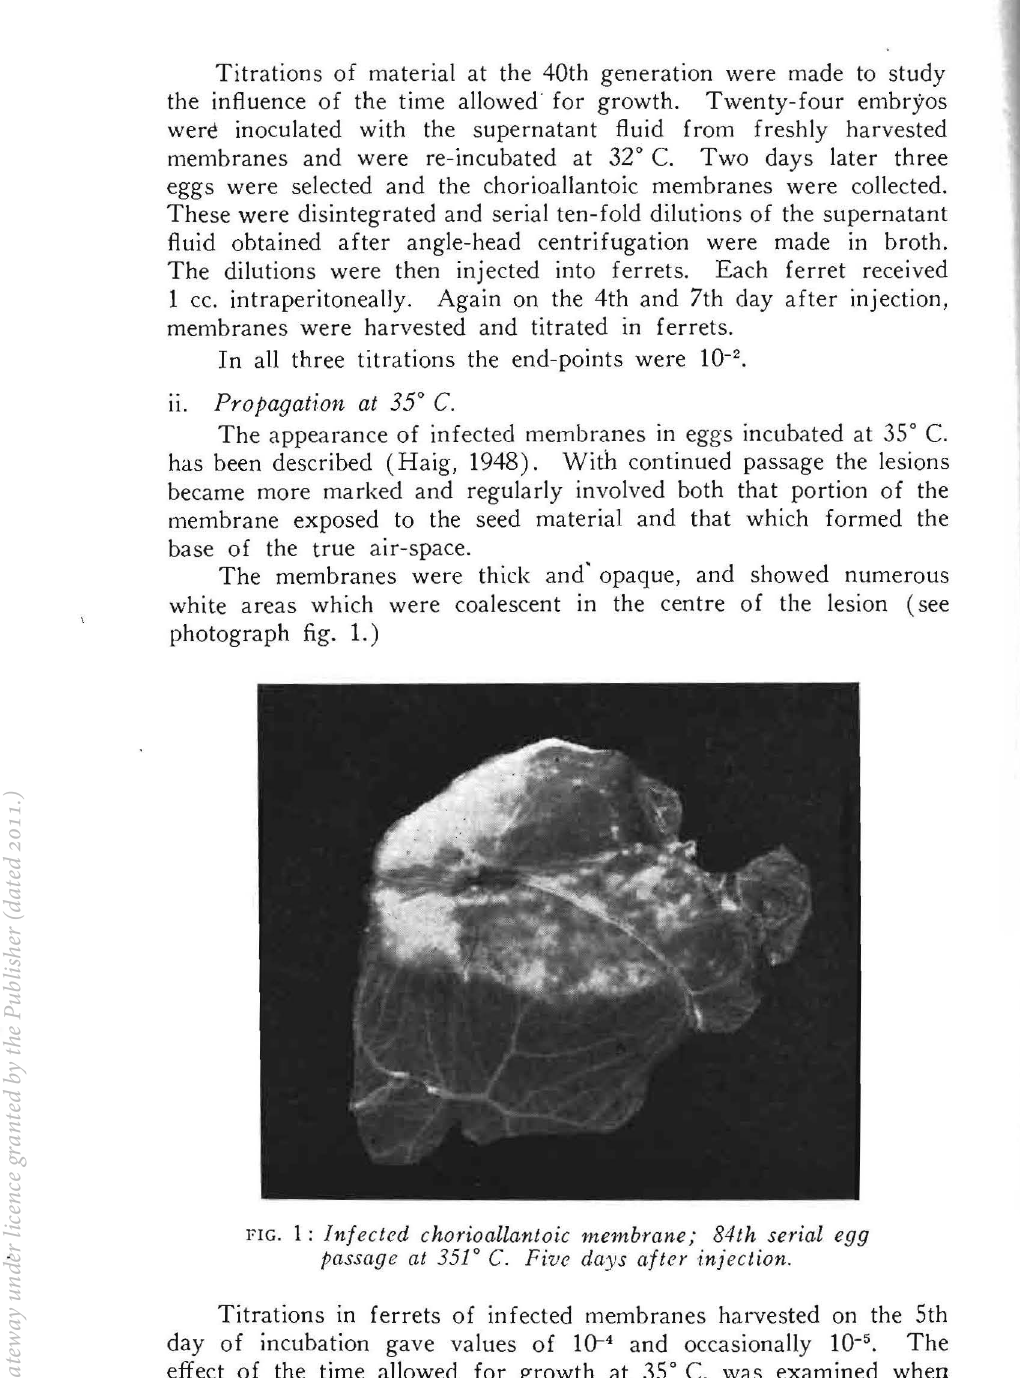
FIG. 1: Infected chorioallantoic membrane; 84th serial egg passage at 35r C. Five days after injection.